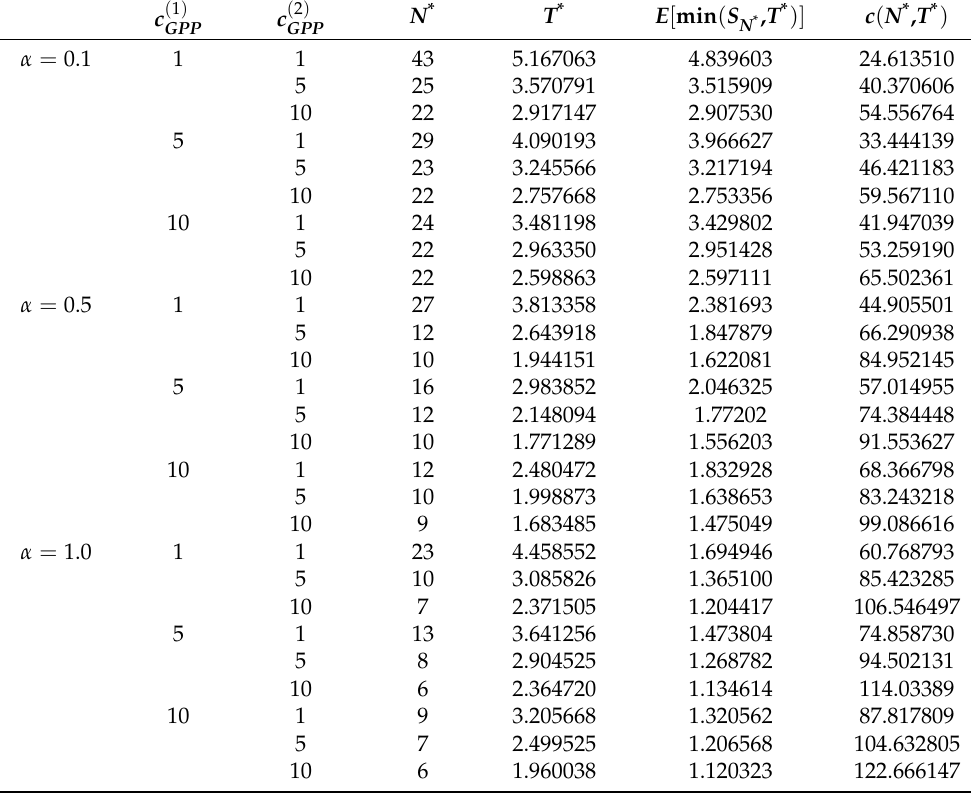
( i ) , i = 1,2 ( c r = 80). GPP